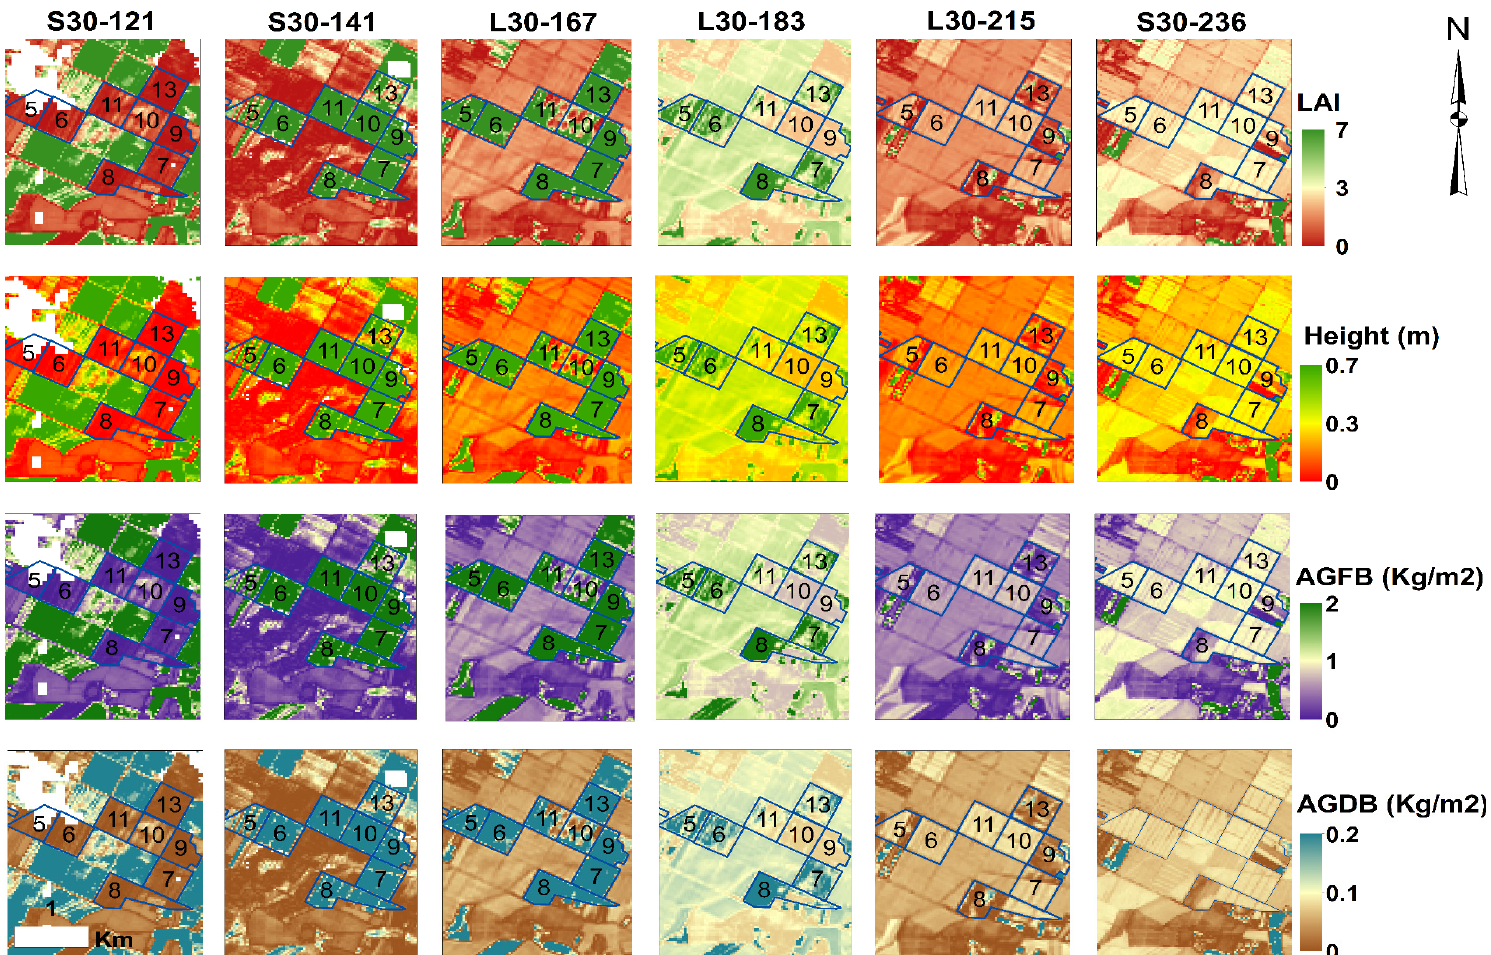
Figure 16 . Spatial and temporal biophysical parameter maps for different satellite (L30 and S30) overpass dates (DOY). The blue delineations indicate the surveyed potato fields during the 2018 season with their corresponding field IDs.